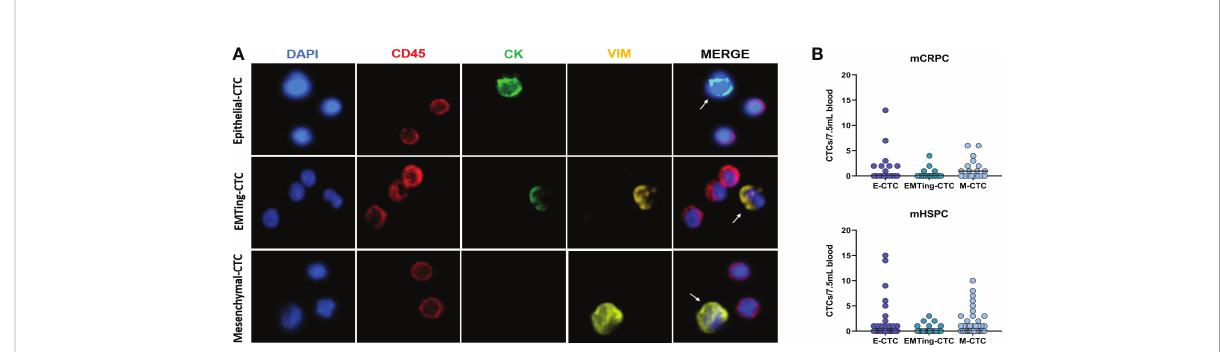
FIGURE 1 Detection of three subtypes of CTCs in PCa patient samples. (A) Three distinct CTC subtypes were identi fi ed by immuno fl uorescence in patient blood samples. Top: One CK+/VIM-/CD45- epithelial-CTC adjacent to two CD45+ leucocytes. Middle: One CK+/VIM+/CD45- EMTing-CTC adjacent to three CD45+ leucocytes. Bottom: One CK-/VIM+/CD45- mesenchymal-CTC adjacent to two CD45+ leucocytes. (B) Individual CTC numbers in each mCRPC and mHSPC patient sample, respectively. Median CTCs number per 7.5mL of blood is shown. Abbreviations: CK, Cytokeratin; VIM, Vimentin.